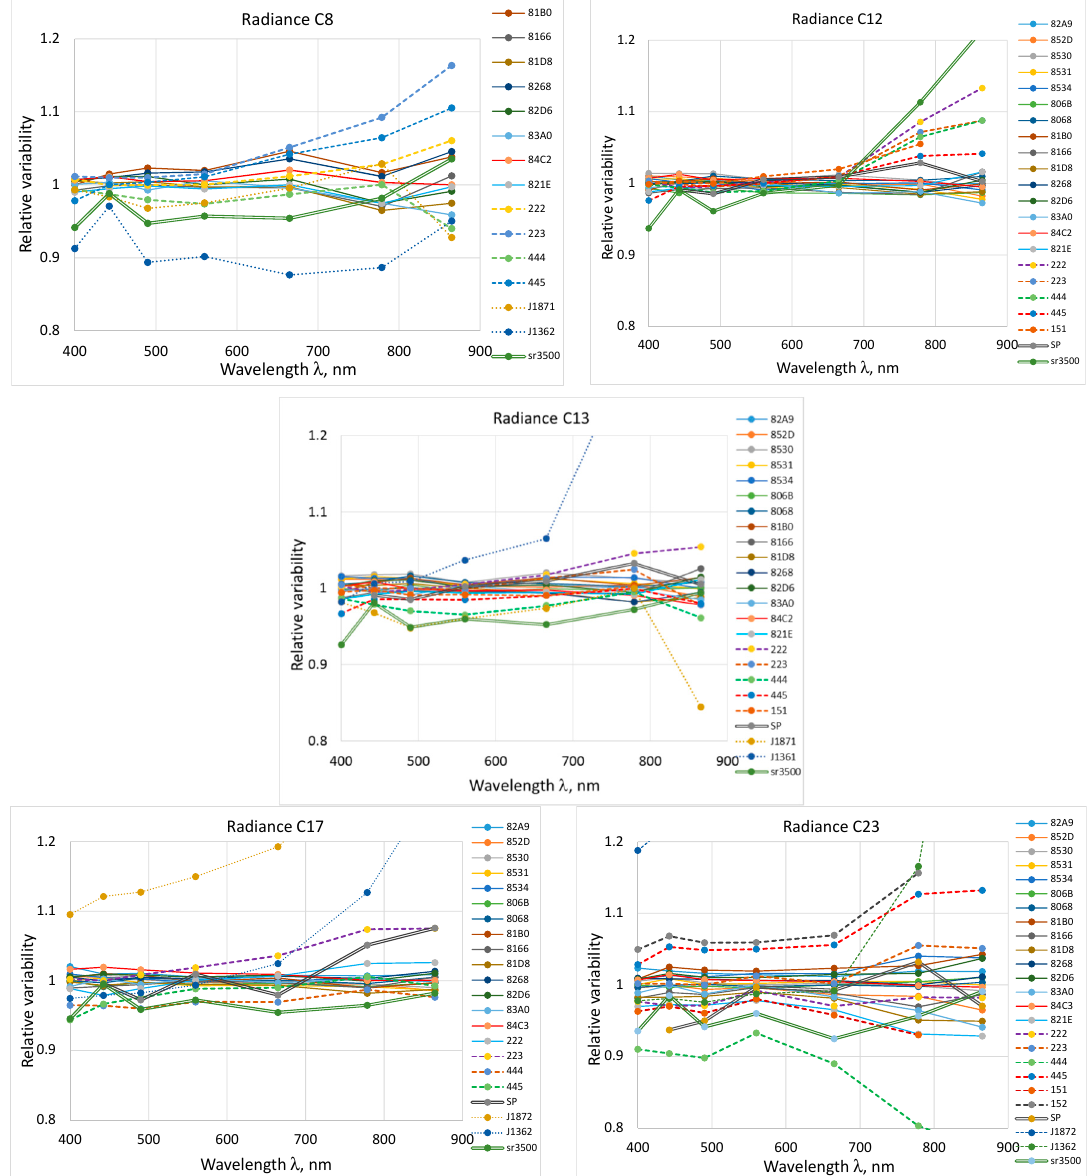
Figure 11. Radiance sensors compared to the consensus value in the outdoor experiment. C8, C12, C13—blue sky; C17—water in cloud shadow at 139° VZA; C23—sunlit water at 130° VZA. Solid lines—RAMSES sensors; dashed lines—HyperOCR sensors; double lines—SeaPRISM (SP) and SR-3500; dotted lines—WISP-3.